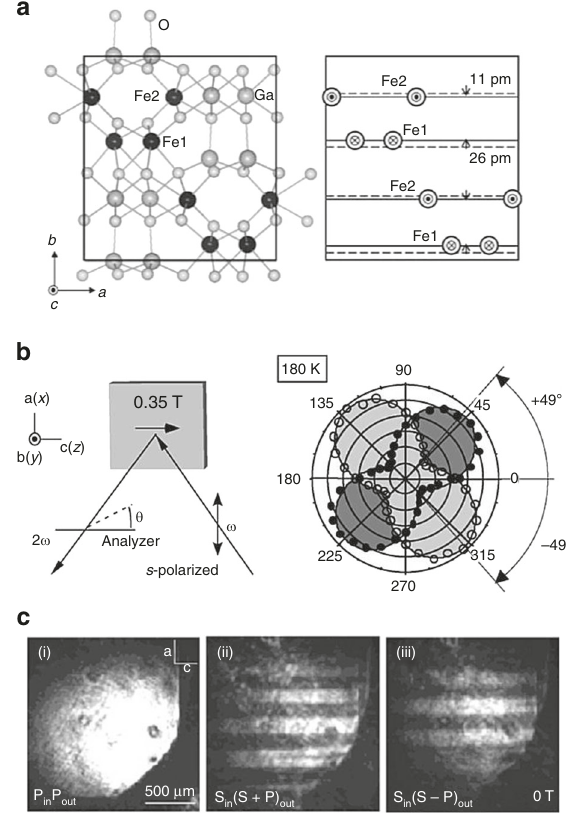
Fig. 5 Second-harmonic (SH) generation from the toroidal moments in multiferroics. a Crystal and magnetic structures of GaFeO 3 . In the right panel, outward (inward) arrows represent the spin direction of Fe1 (Fe2) atoms antiparallel (parallel) to the c axis. Horizontal solid lines represent the shifted positions of Fe ions along the b axis from the symmetric positions (dashed lines) of FeO 6 octahedra. Note that the shifted directions of Fe1 and Fe2 atoms are opposite to each other. Reprinted fi gure with permission from ref 60 . Copyright (2005) by the Physical Society of Japan.